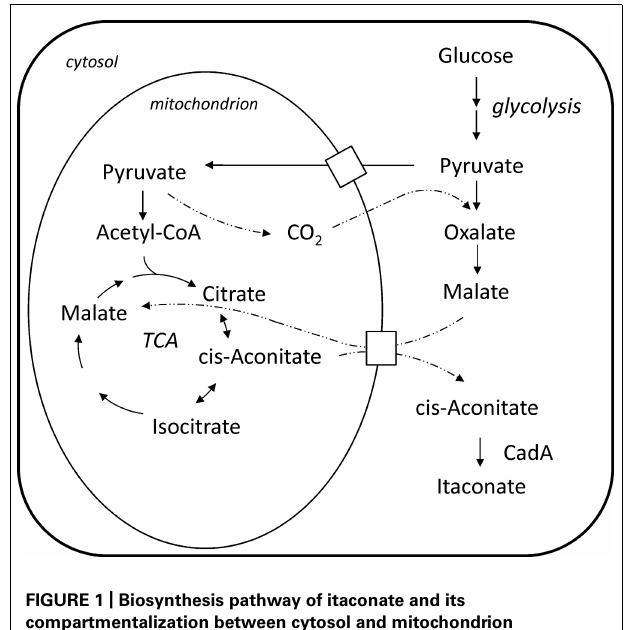
FIGURE 1 | Biosynthesis pathway of itaconate and its compartmentalization between cytosol and mitochondrion in the A. terreus cell; note: cis -aconitate transport is